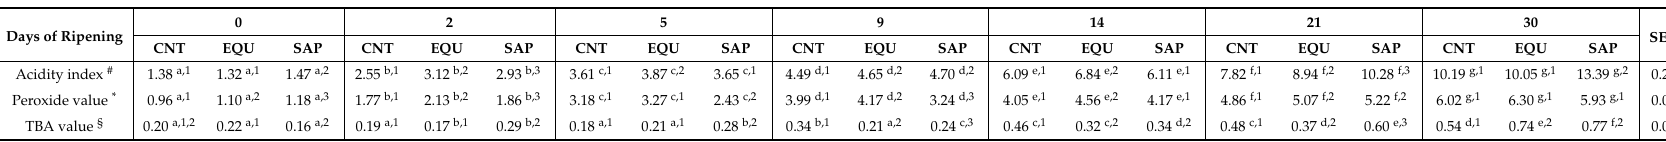
Table 7. Evolution of the fat parameters along the manufacturing process of Galician chorizo made without and with starter cultures (means of three replicates in each sausage